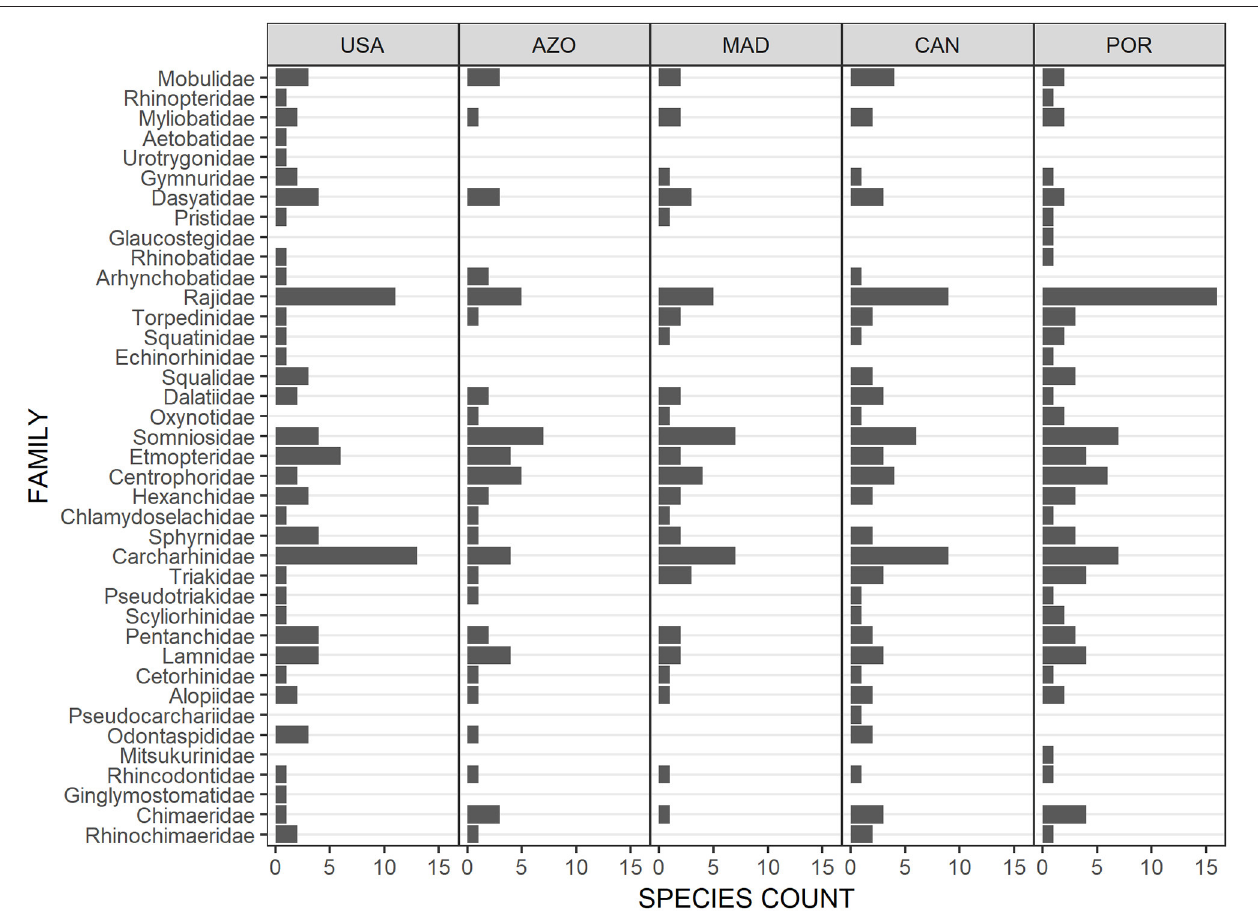
FIGURE 3 | Configuration of elasmobranch diversity by families across the North Atlantic. USA, United States east coast; AZO, Azores; MAD, Madeira; CAN, Canaries; POR, Portugal continental shelf.